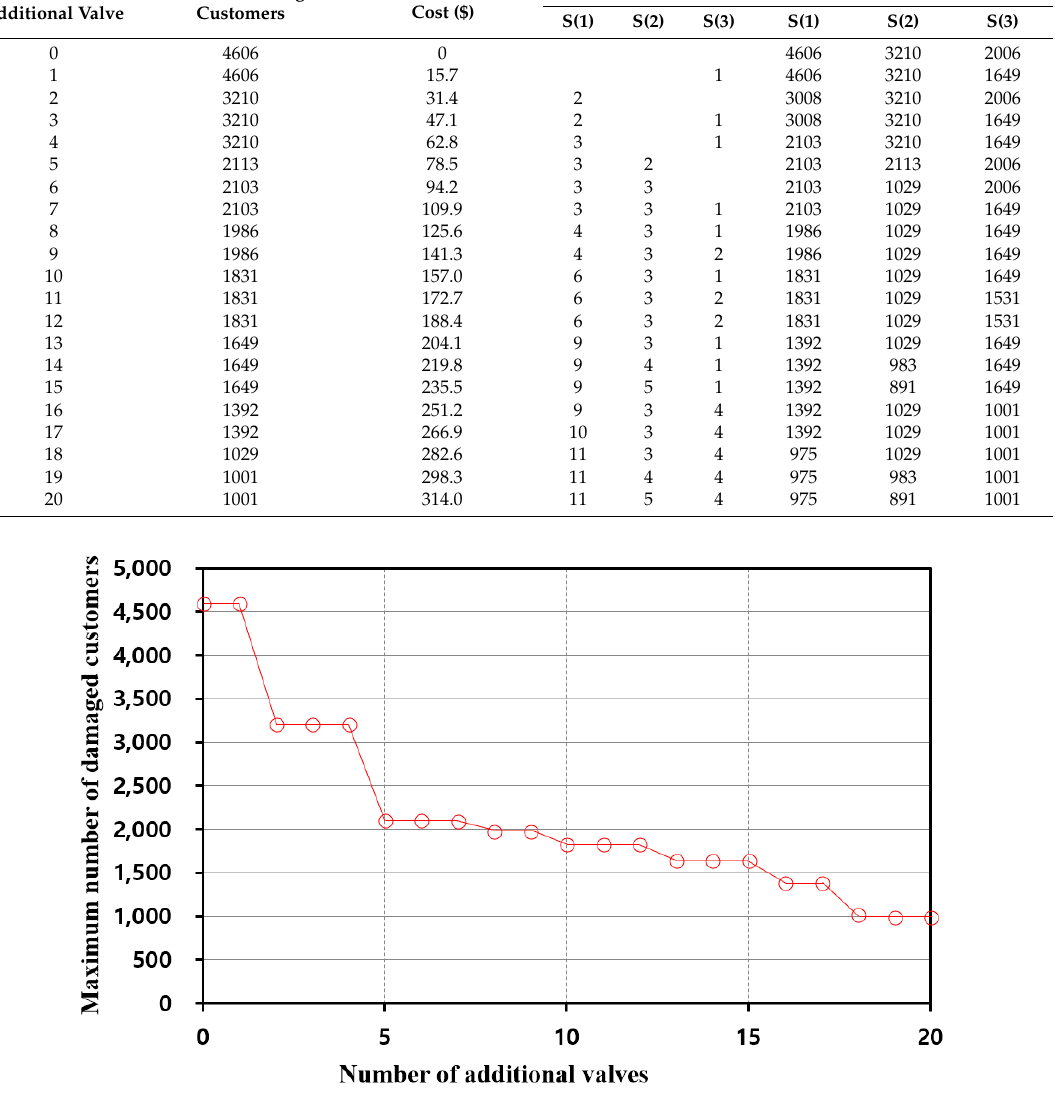
Figure 11. Relationship between the number of valves and maximum number of customers affected in